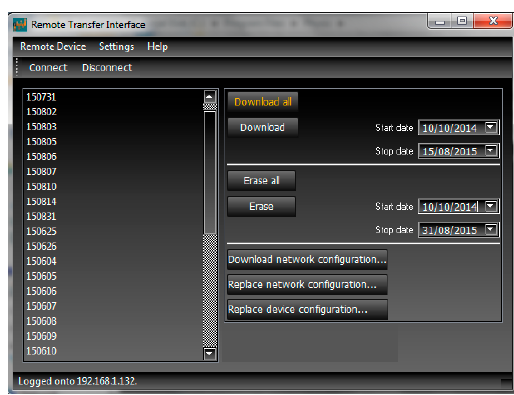
Figure 24. Remote Transfer interface.